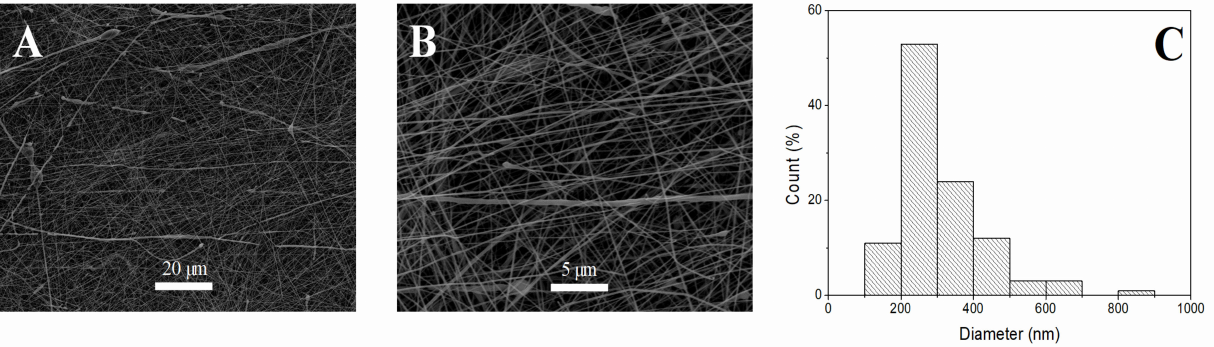
Figure 1. SEM images of PCL/elastin scaffolds at different magnifications: ( A ) 1000 × and ( B ) 4000 × . The fiber size distribution was also included ( C